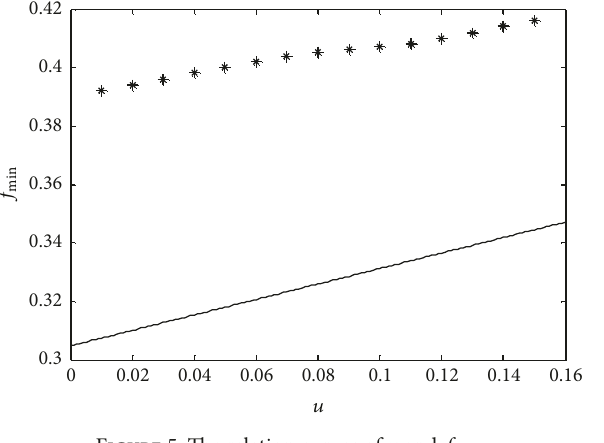
Figure 5: The relation curves of 𝑢 and 𝑓 min .